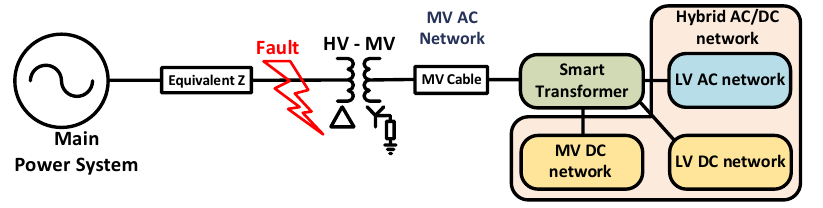
Figure 1. Overall structure of the complete computational model for the test